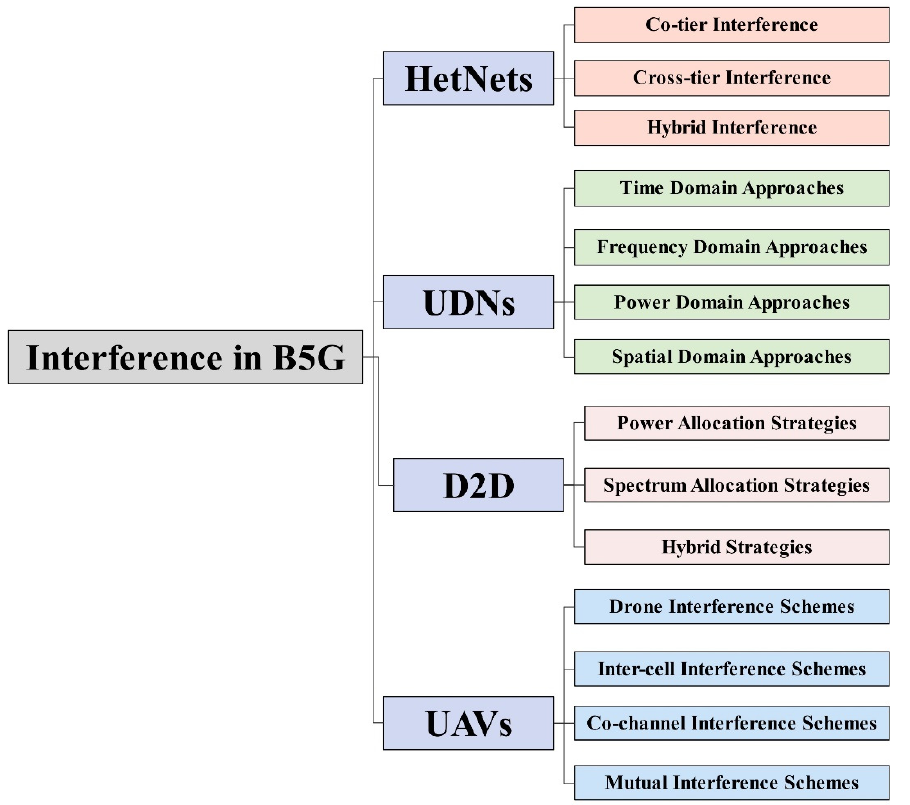
Figure 3. Interference in B5G networks.